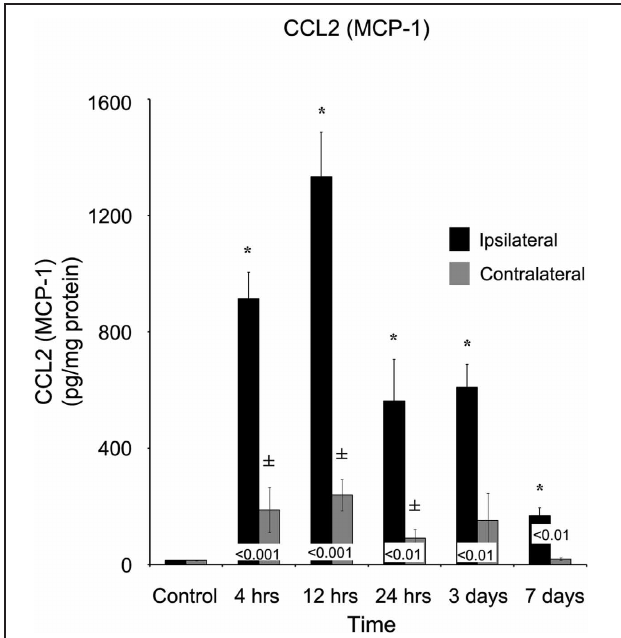
FIGURE 7 | CCL20 concentrations increase in the ipsilateral cortex following a controlled cortical impact. Within four hours of a brain injury, CCL20 increases ( p < 0 . 05) in the ipsilateral cortex in comparison to both control and contralateral tissue. The expression of CCL20 peaked 24 hours after injury, and did not return to levels observed in control or contralateral tissue until seven days post-injury. At no time, was the expression of CCL20 observed to be elevated ( p > 0 . 05) in the contralateral cortex in comparison to control. All values are mean ± SEM, n = 5. ∗ At each time point noted, ipsilateral differs from control tissue, p < 0 . 05. Differences between the ipsilateral and contralateral cortices are denoted by placing the appropriate p -value above the two